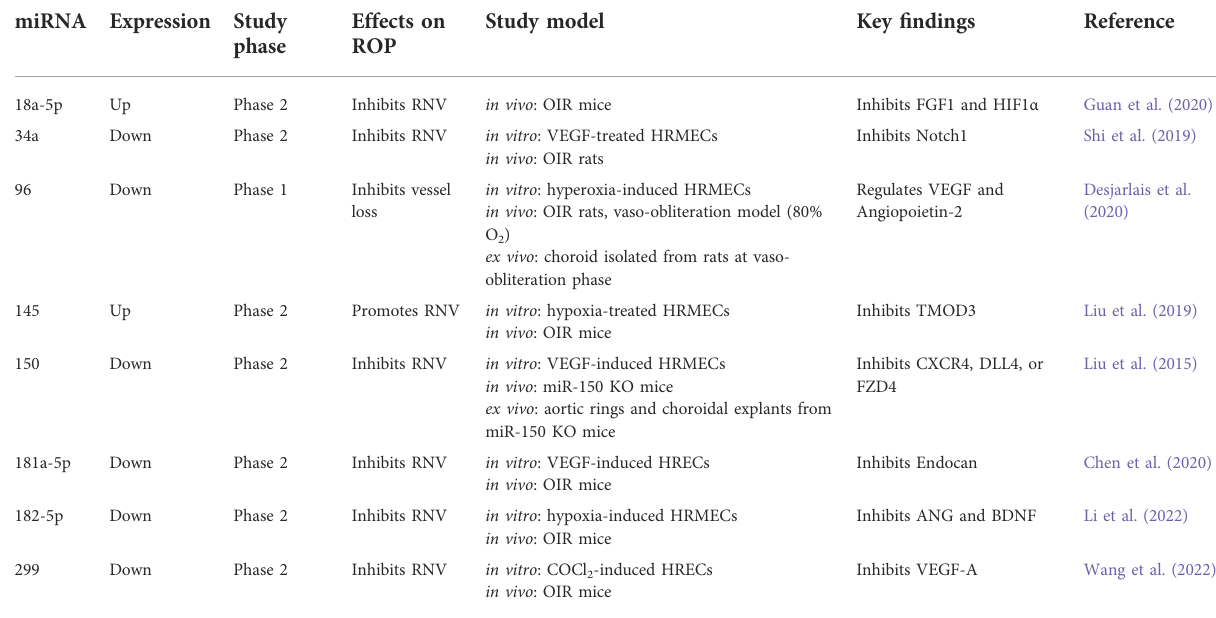
TABLE 1 microRNAs regulating ROP.